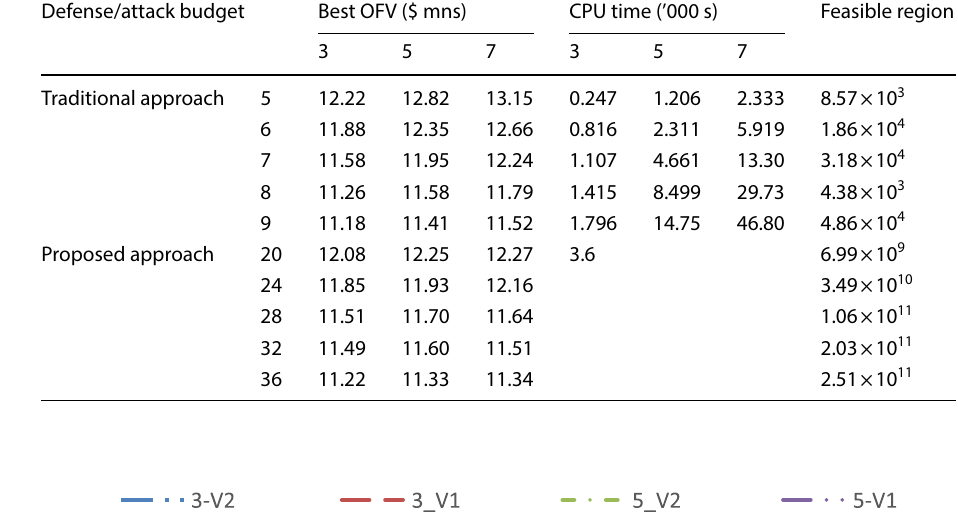
Defense/attack budget Traditional approach